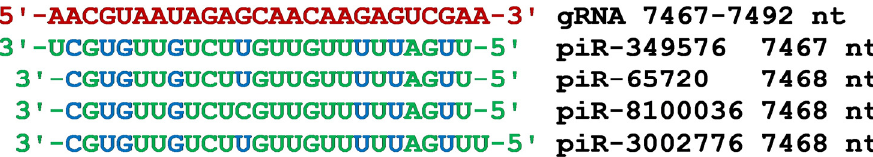
Figure 6. Nucleotide sequences of the four piRNA BSs cluster in the region from 7467 nt to 7492 nt of gRNA and the nucleotide sequences of piRNAs. Note: The piRNA nucleotides that form canonical pairs with gRNA are highlighted in green and non ‐ canonical pairs are highlighted in blue. The names of the piRNAs are followed by the beginning of their BSs.